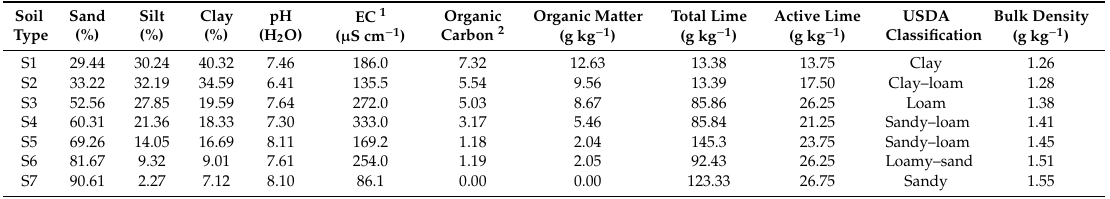
Table 1. Physical–chemical properties of the di ff erent types of